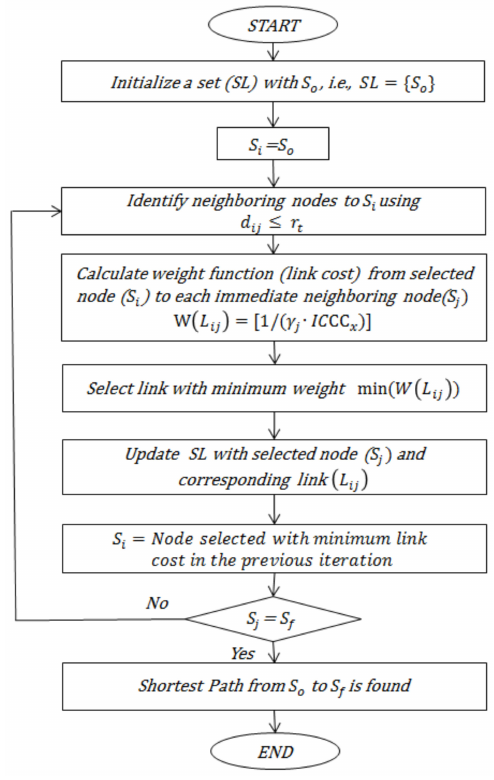
Figure 5. Flowchart of data transmission phase.